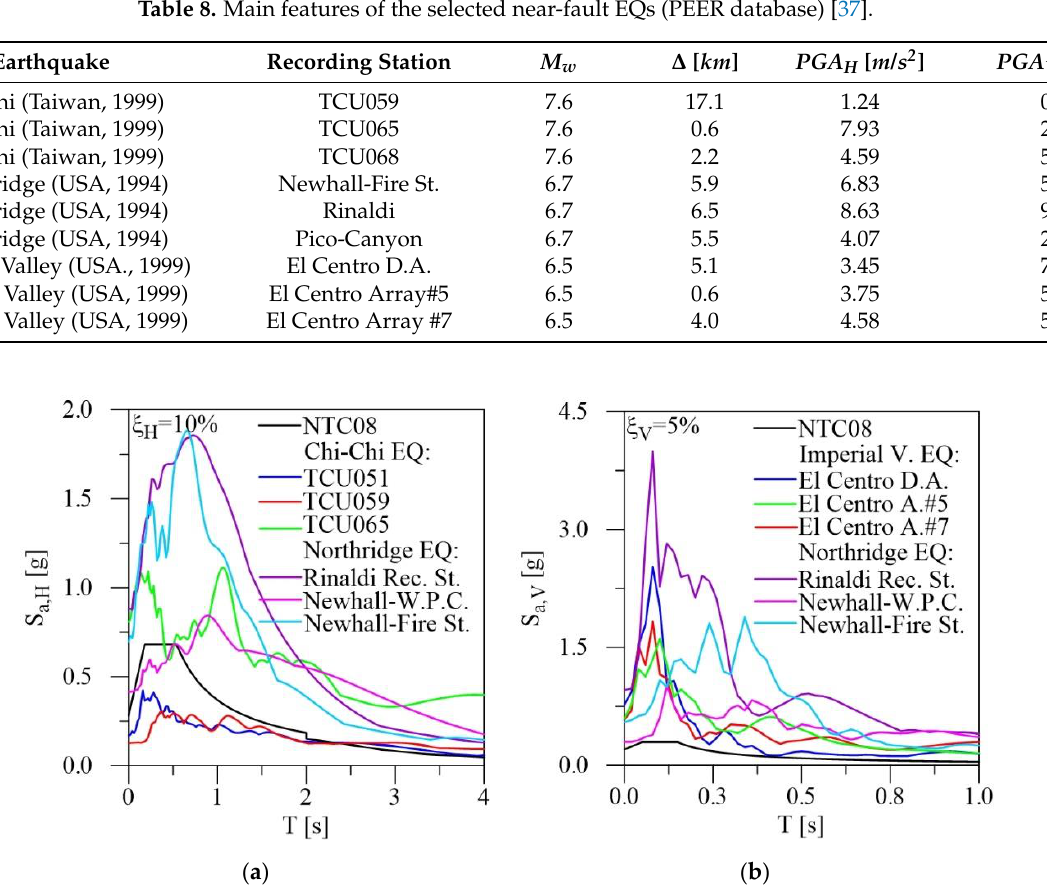
Figure 3. Horizontal ( a ) and vertical ( b ) acceleration spectra.